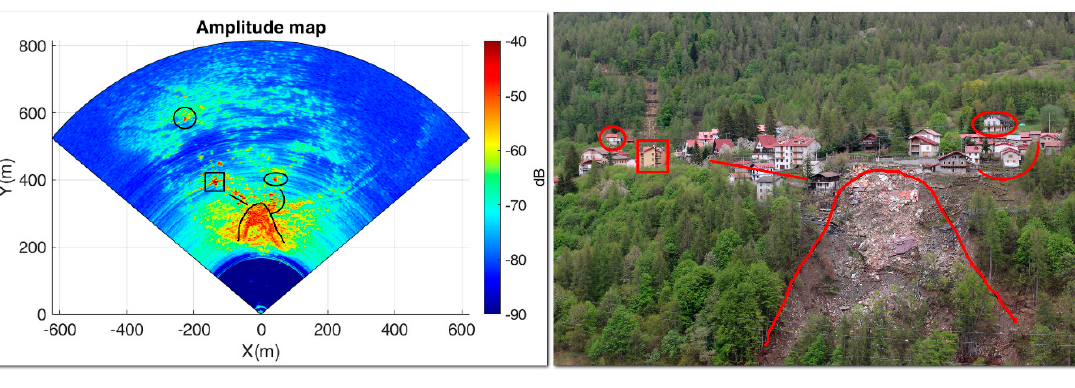
Figure 12. ( A ) Amplitude image (VV) of a radar acquisition in radar coordinates with some outstanding targets indicated. ( B ) Picture of the main area with indicated the areas marked in Figure 12A.